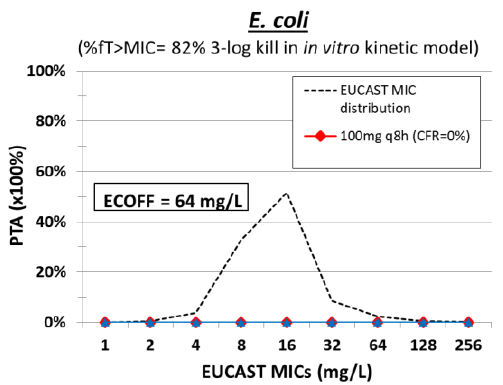
Figure 6. Probability of target attainment (PTA) of nitrofurantoin at different dosing regimens against isolates with increasing MIC. The cumulative fraction of response (CFR) is shown for a col- lection of isolates with the EUCAST MIC distribution.